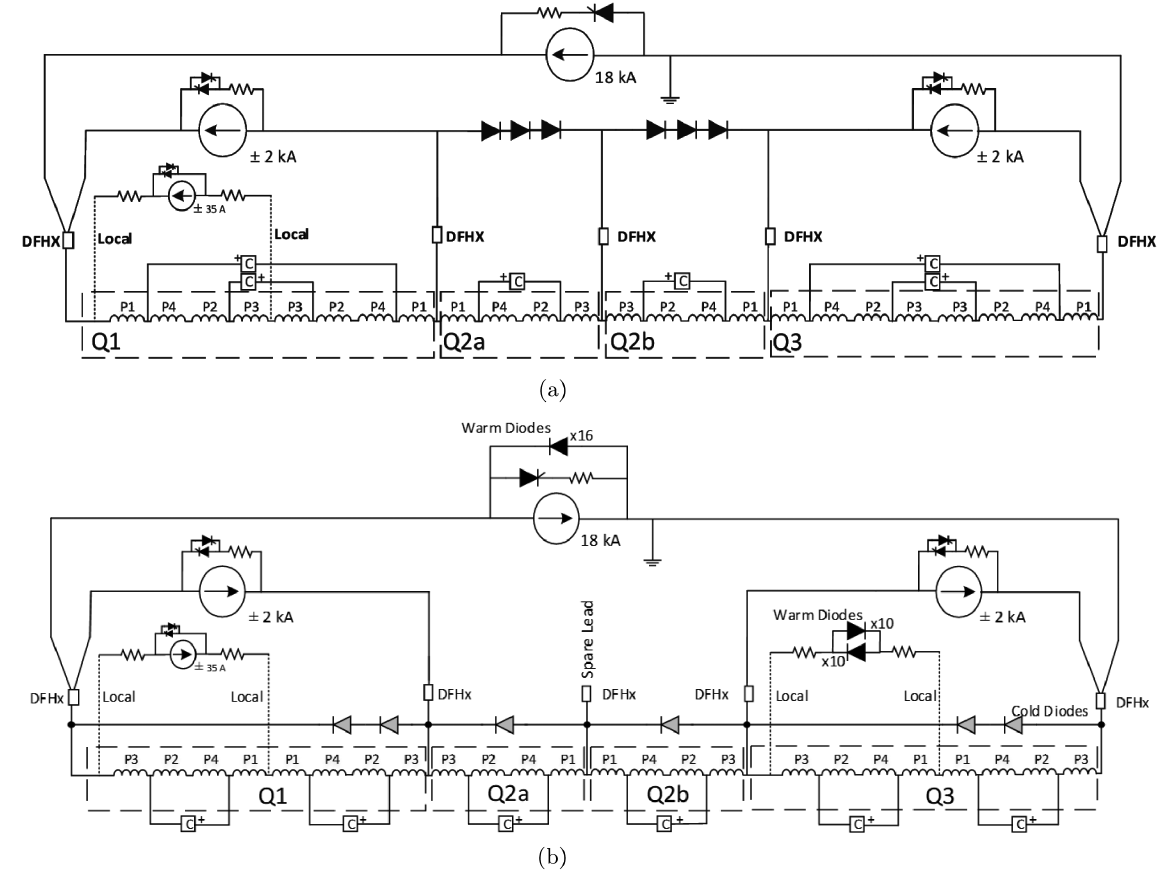
FIG. 9. The baseline CLIQ connection scheme (top) as of the writing of this article [29,45] vs the new baseline to be active from HLLHC TDR v. 1.0 [46]. The magnets, Q1, Q2, and Q3 are encircled by dashed lines. All three magnets consist of two identical halves, designated a and b, but only for Q2 the halves are separate. The magnet poles are designated by P1 to P4 and the CLIQ units by C.